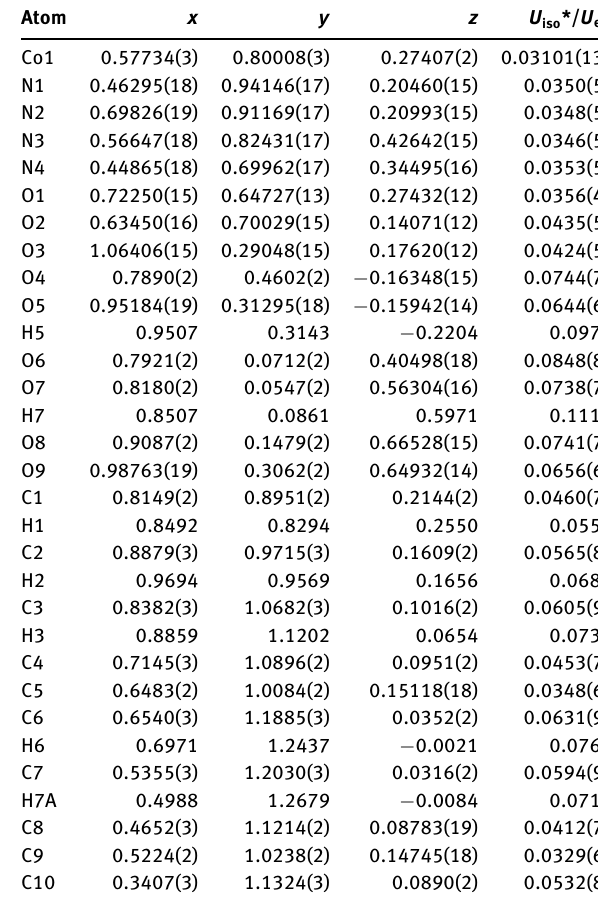
Table 2: Fractional atomic coordinates and isotropic or equivalent isotropic displacement parameters (Å 2